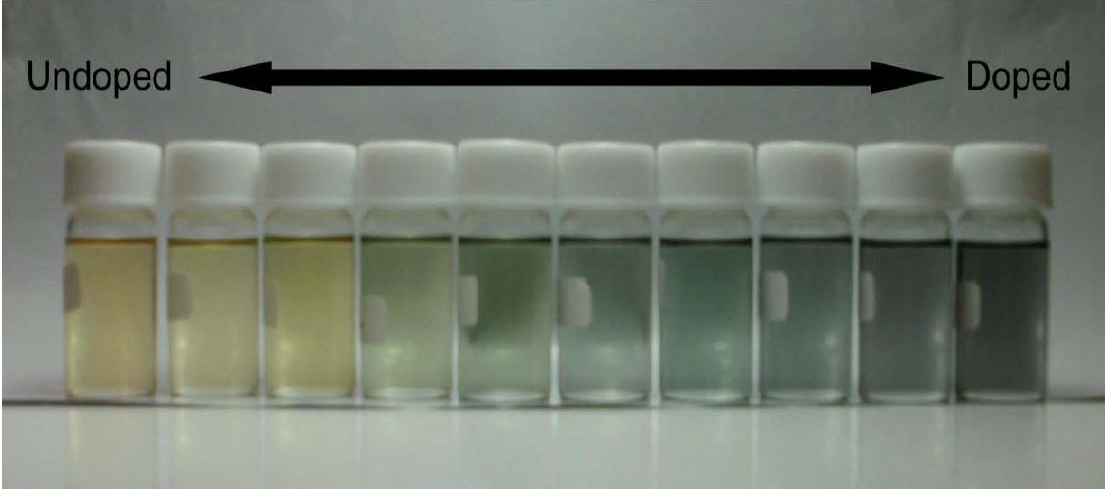
solution from orange to green with iodine doping. 3